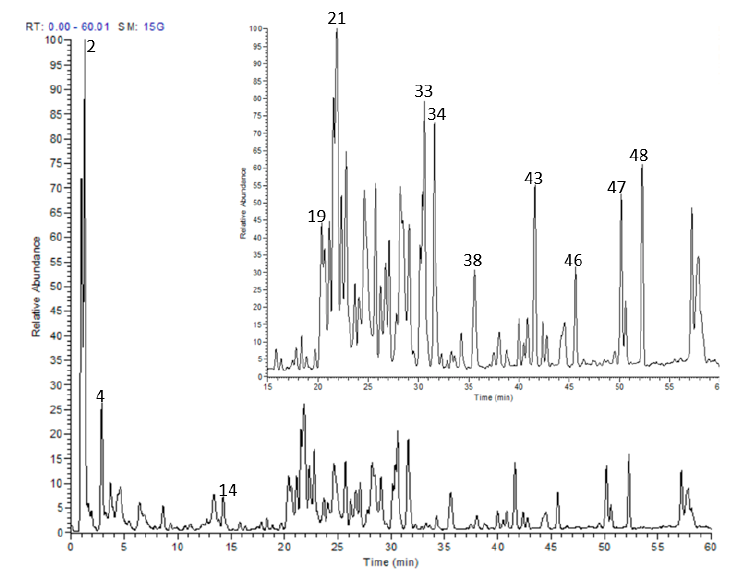
Figure 1. LC-MS profile of H. abyssinica leaves methanolic extract.